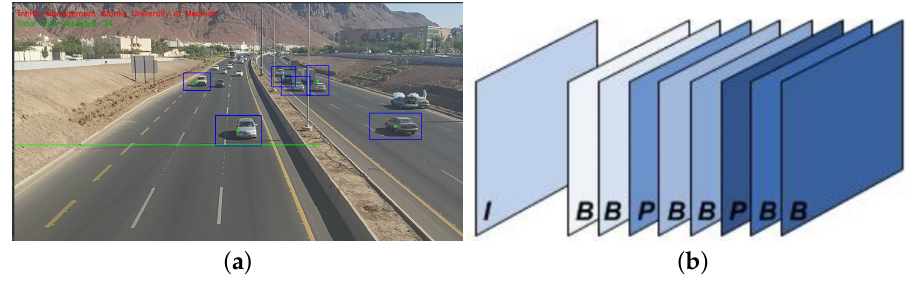
Figure 1. ( a ) An MPEG video sequence ( b ) MPEG video sequence